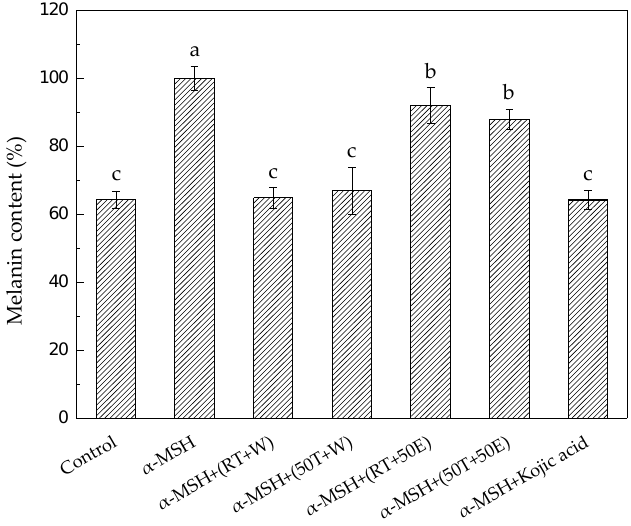
Figure 9. Melanin content in B16/F10 cells treated with the four extracts and kojic acid. Treatment means with the same letter are not significantly different.